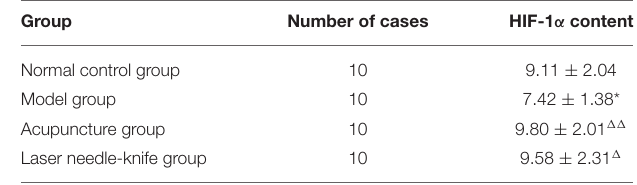
TABLE 6 | Comparison of HIF-1 α content in CSA rabbits ( ¯ x ± S) (pg/mg).